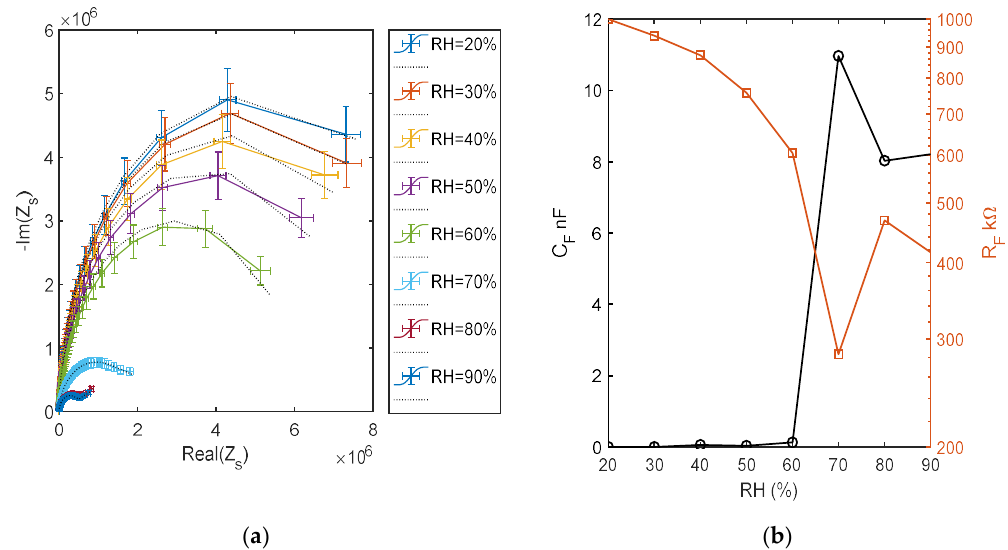
Figure 16. ( a ) Impedance spectra in the range of 50 Hz–80 kHz at different and constant RH levels, impedance imaginary part versus real part. Colored lines: measured spectra (as per legend) and dotted black lines: equivalent model fitting. ( b ) Estimated parameters of the fitted equivalent circuits.